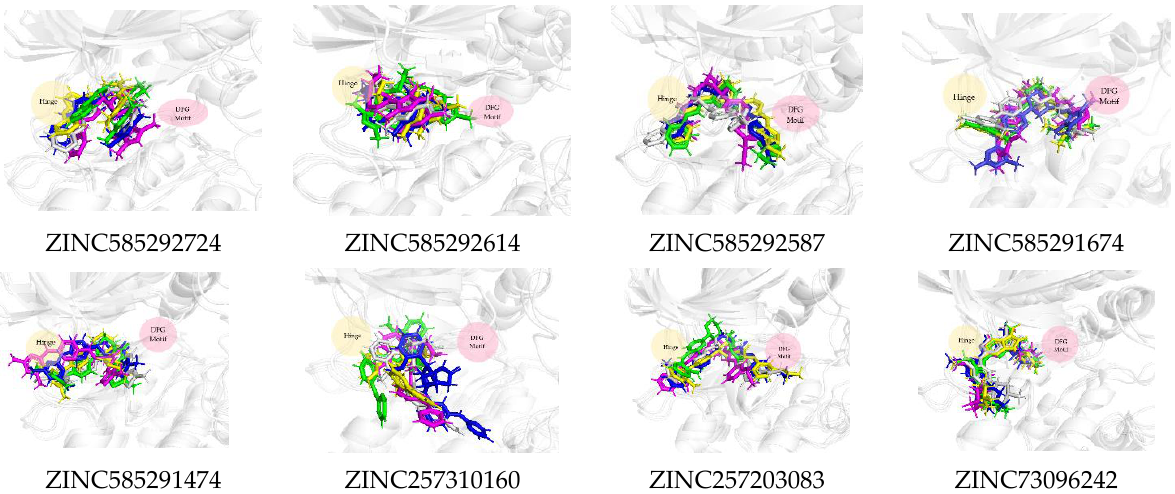
Figure 11. The superimposed ligand binding poses of hit compound at 0 ns (green), 100 ns (grey), and 200 ns (blue) in complexes with CDK4.